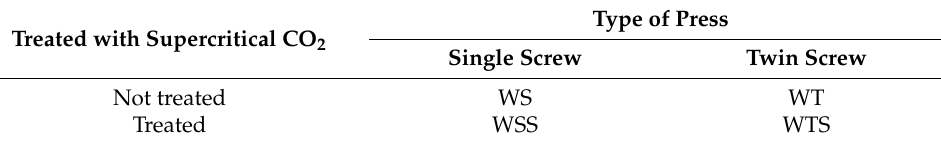
Table 2. Abbreviations of the four different types of white alfalfa protein concentrate produced and investigated in this study. Type of Press Treated with Supercritical CO 2 Single Screw Twin Screw Not treated WS WT Treated WSS